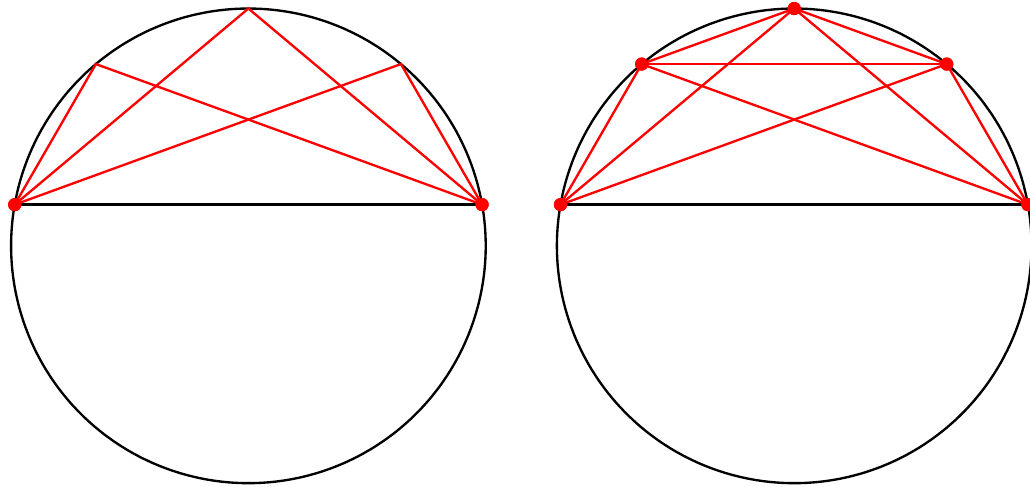
Figure 5 . Visualization of the conjectured rules governing solutions describing SU(2) Cardy branes for k = 9 and J = 2 background. The initial D-brane is denoted by the black line and the possible i configurations of final D-branes by red lines. The left figure illustrates the relation (4.5). In this figure, all red lines touch the black one at one point. On the right, there is an illustration of the more generic relation (4.6), where the points and lines form a net based on 5 points regularly positioned in the